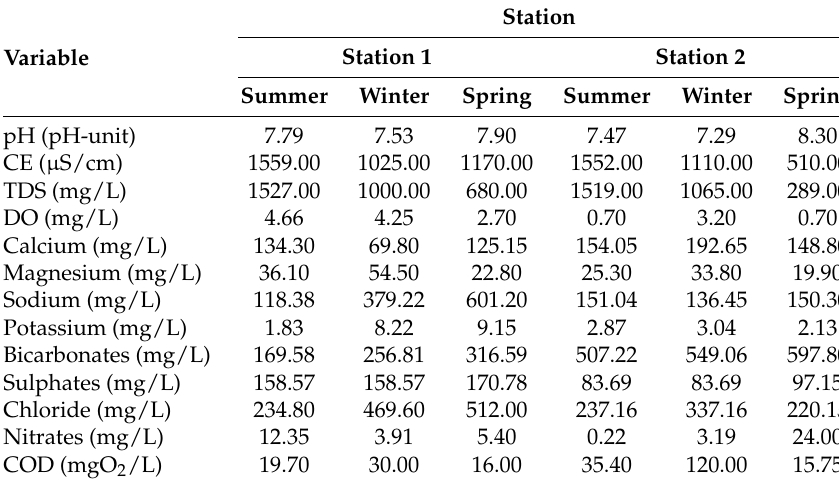
Table 7. Analytical results of the two samples.